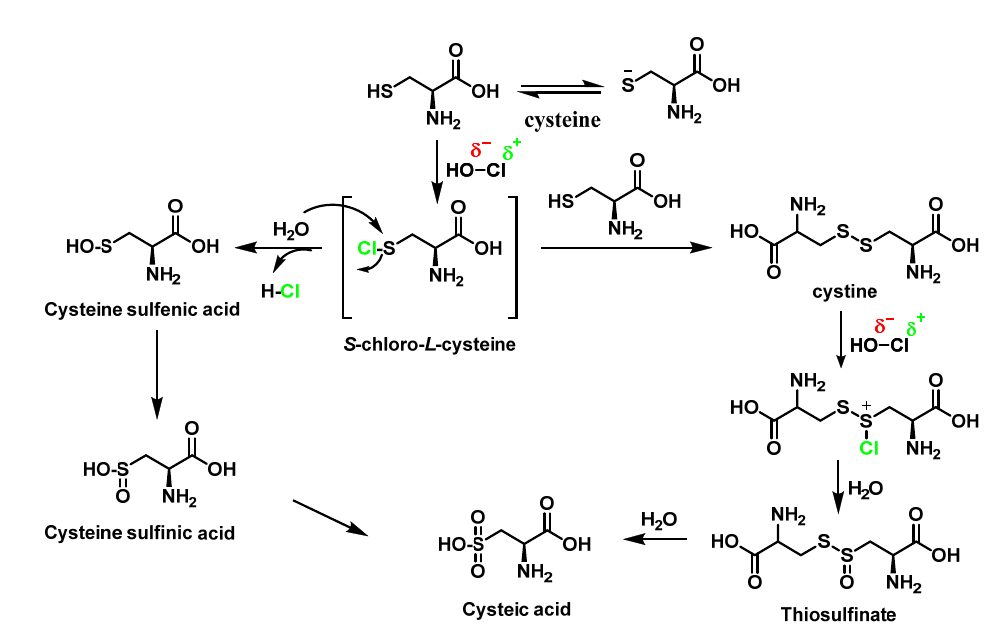
Figure 29. Summary of products of oxidation of Cys and Cystine residues by HOCl. Cysteine can also react with N -Cl-taurine to generate sulphenyl chloride, as shown in Figure 30.